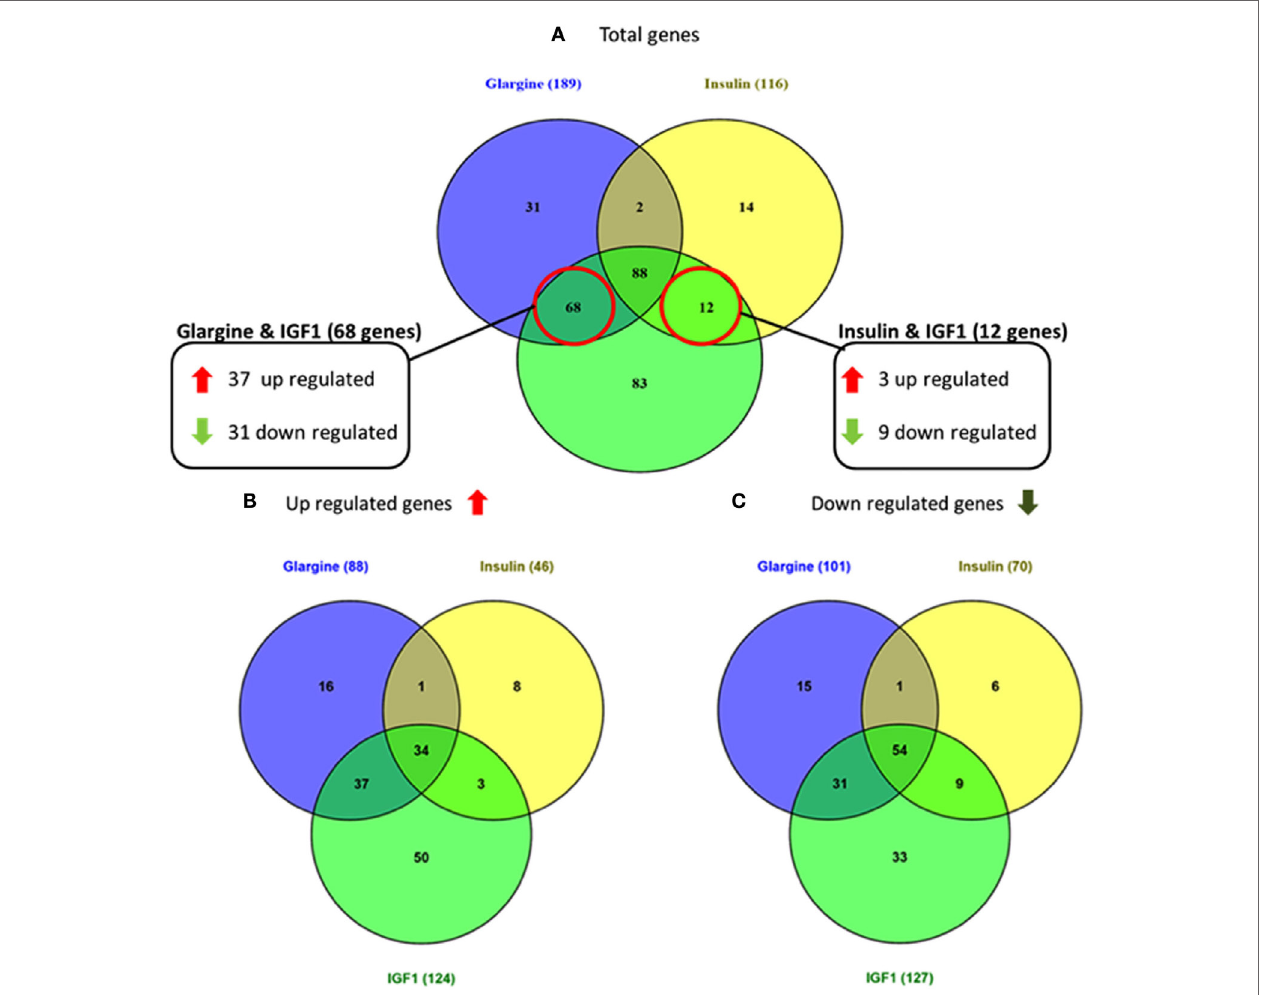
FigUre 3 | Venn diagrams showing the number of differentially expressed genes in response to glargine, regular insulin, or IGF1 in ECC-1 cells. (a) Number of total genes induced after IGF1, glargine, or regular insulin treatment; (b) number of upregulated genes; (c) number of downregulated genes. The Venn diagram shows the number of genes uniquely expressed after response to the indicated treatment. The intersection of the circles shows the number of genes commonly expressed (up- or downregulated). The genes included in this analysis showed a 1.5-fold change in expression compared to the control with a pFDR <